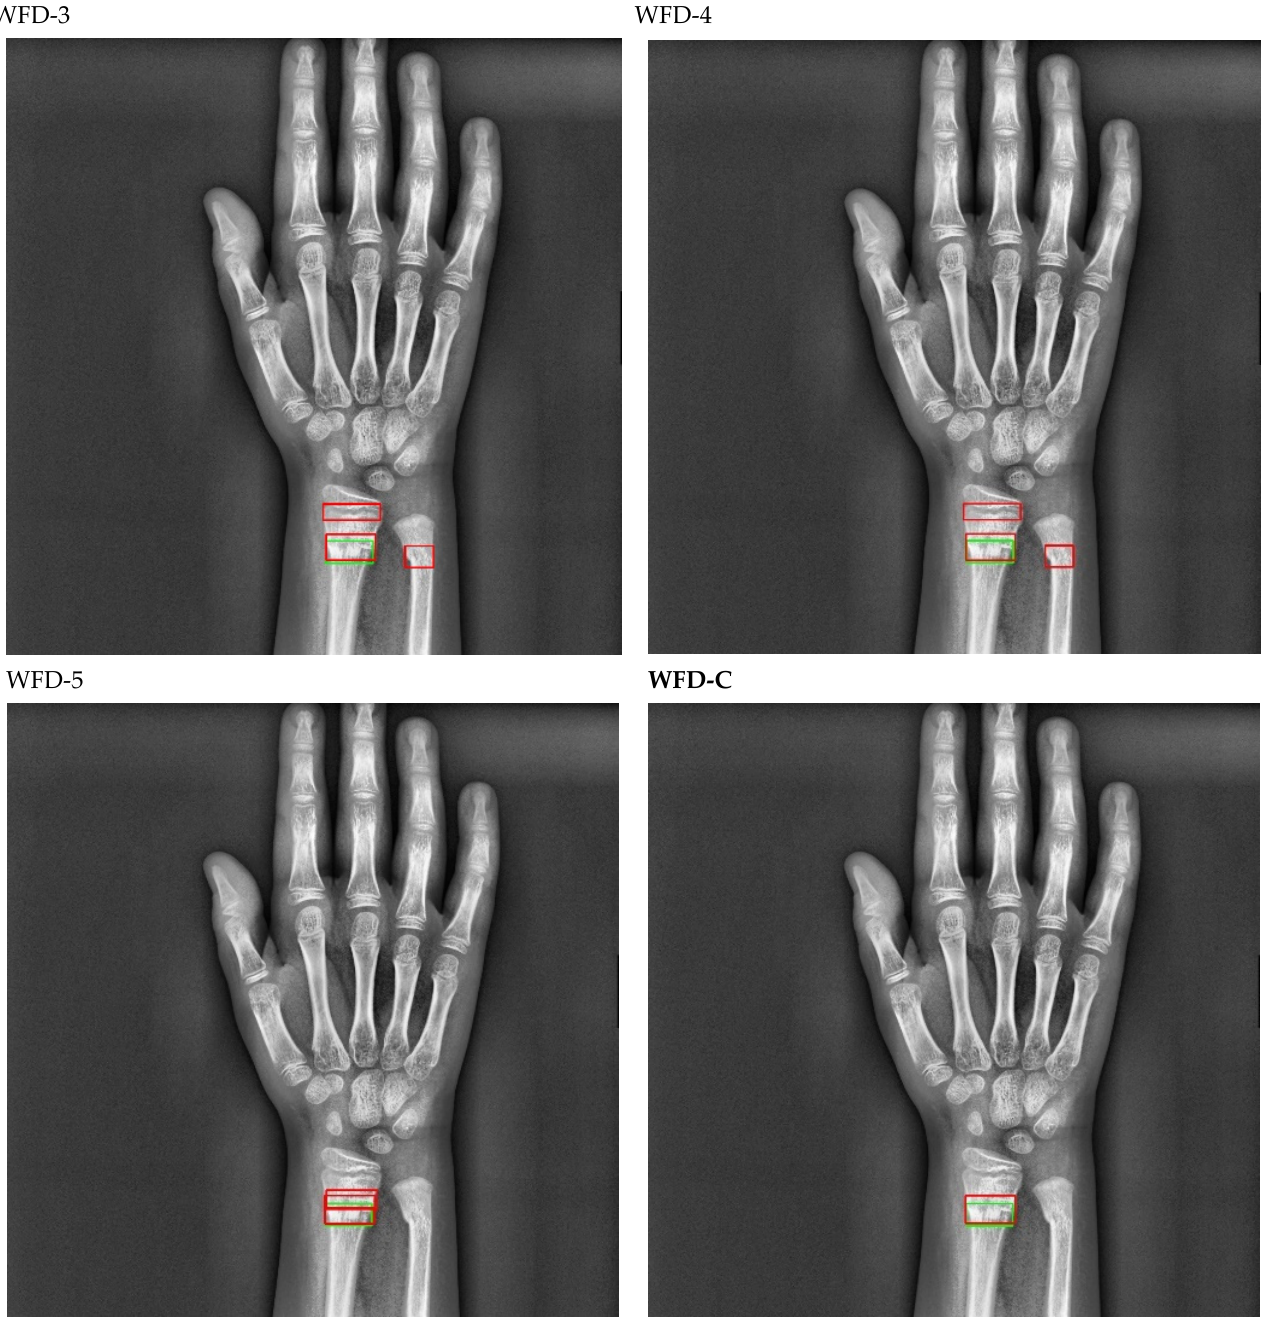
Figure 20. Sample of right wrist fracture results [ground-truth bounding box (green), predicted bounding box (red)].